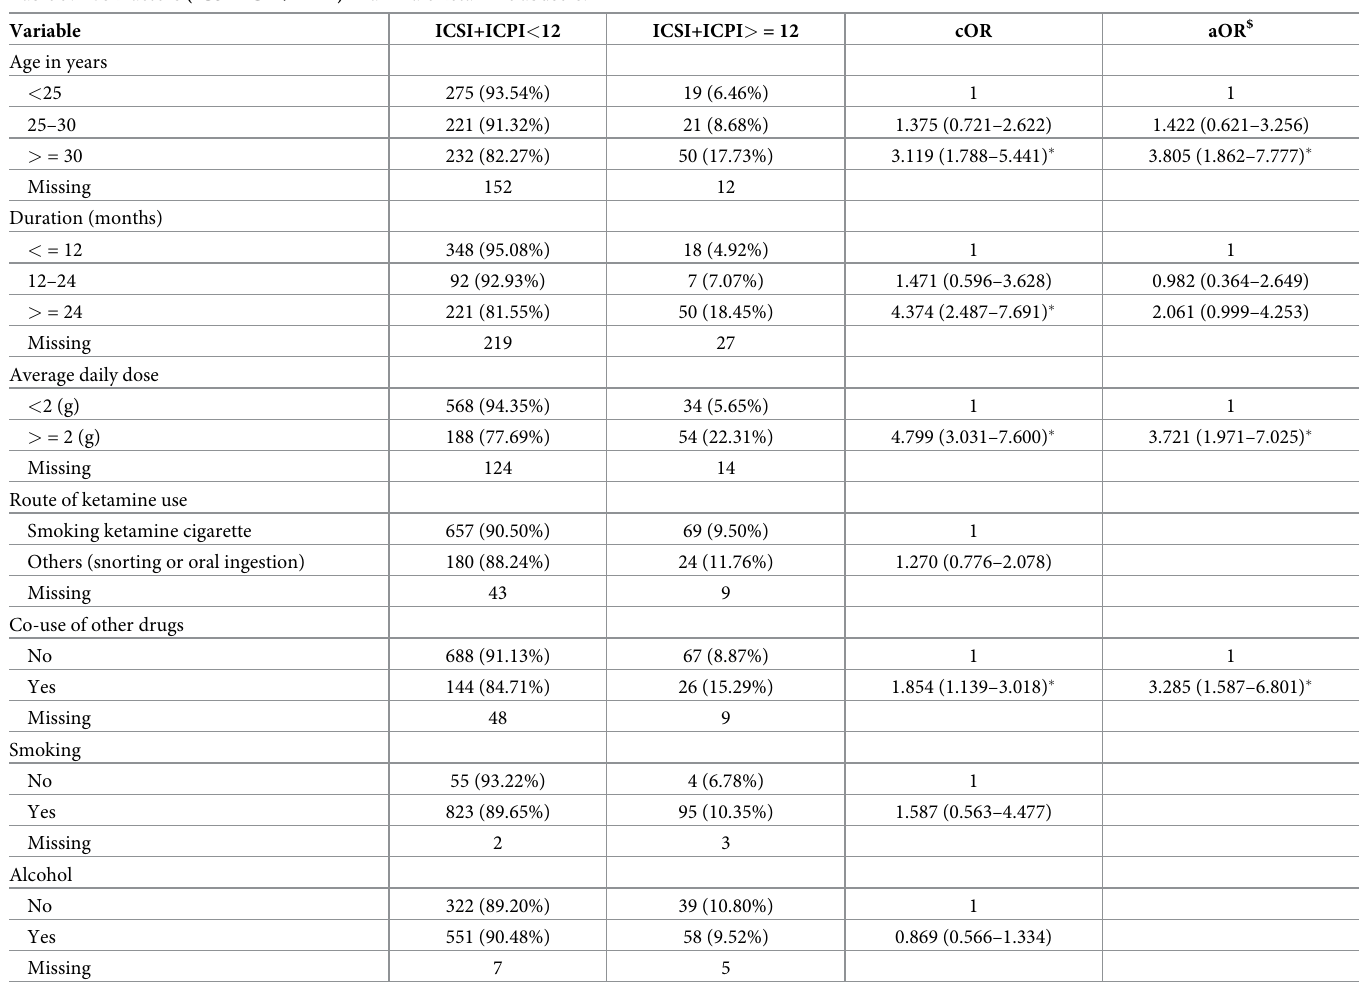
Table 5. Risk factors (ICSI+ICPI > = 12) in all male ketamine